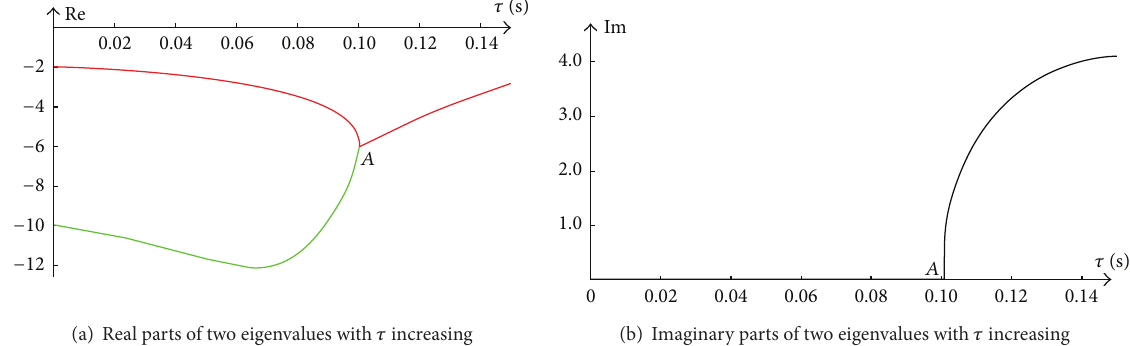
Figure 12: Real and imaginary parts of two eigenvalues.